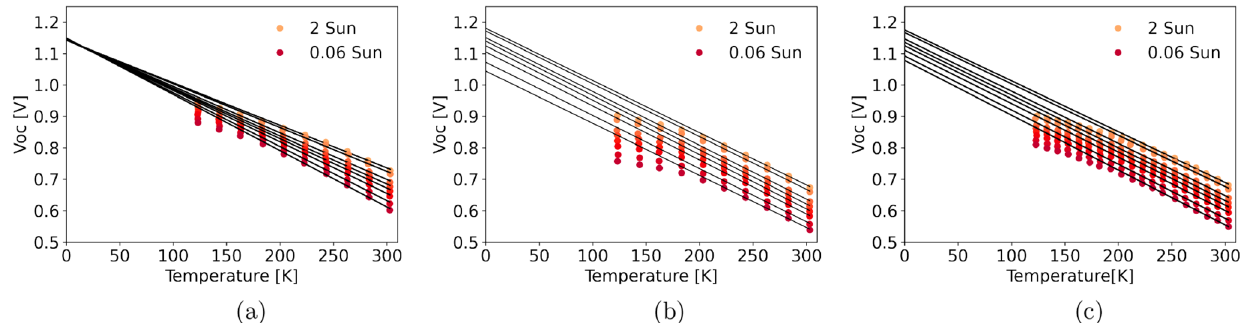
Fig. 5. Extrapolation of V OC at 0K for (a) CdS reference, (b) Zn 1 (cid:1) x Mg x O buffer (c) Zn 1 (cid:1) x Mg x O buffer after light soaking for 1h at 1